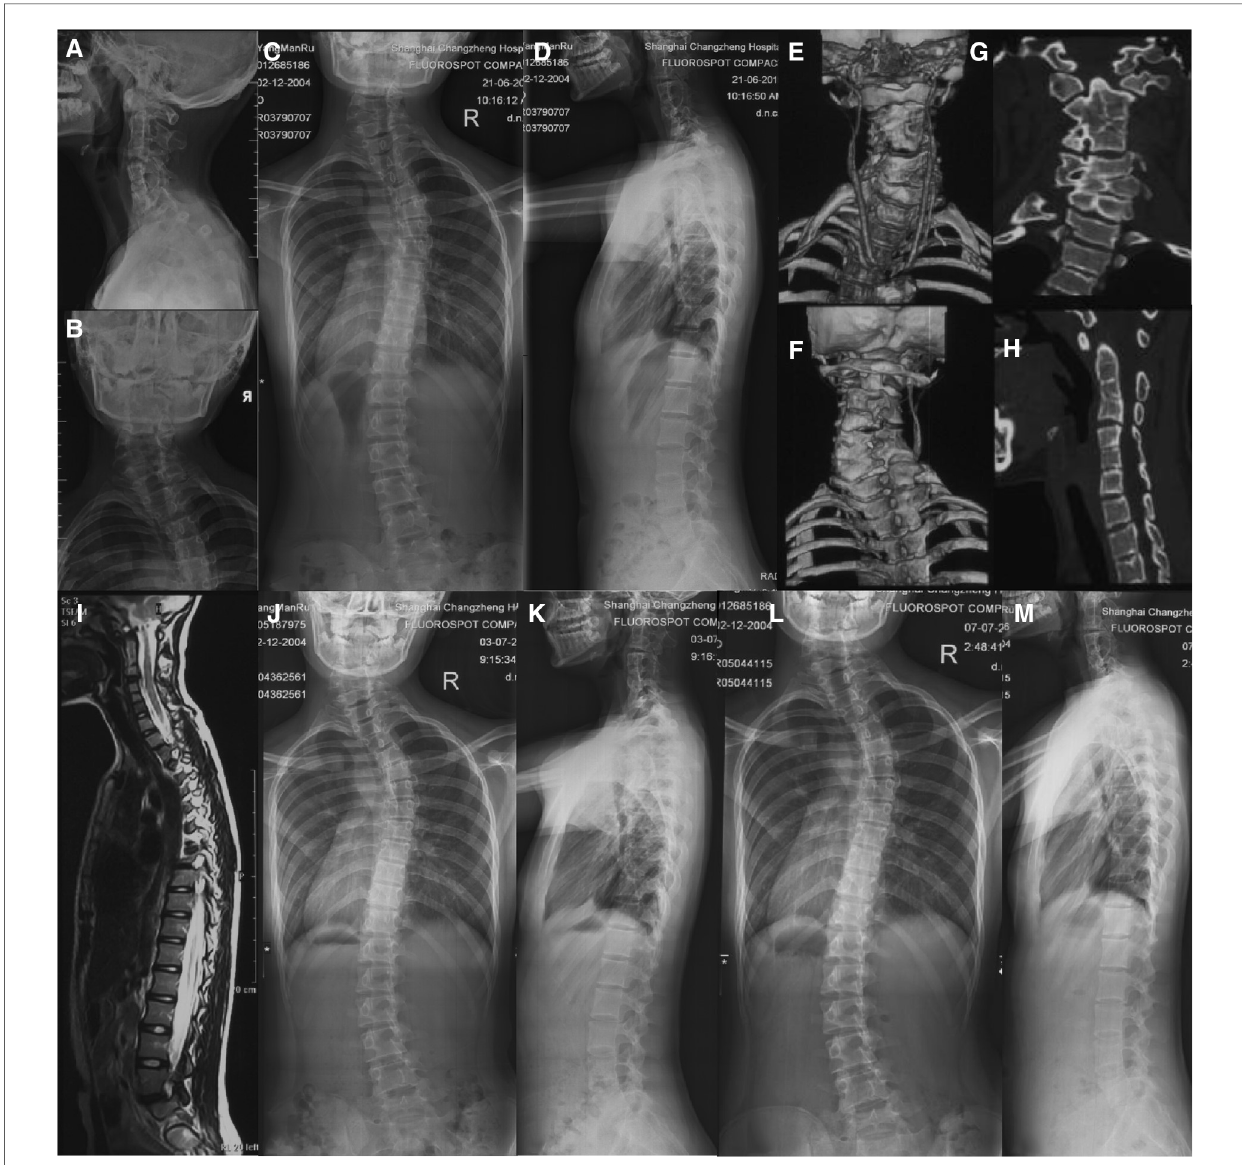
FIGURE 6 A case of Type IIIA cervical hemivertebra, female, 14 years old. ( A – I : the left hemivertebra of C4 and the right hemivertebra of C6, with no obvious deformity; Figures ( J,K ): no progression of scoliosis after 1 year; Figures ( L,M ): 2 The scoliosis has not progressed after 2